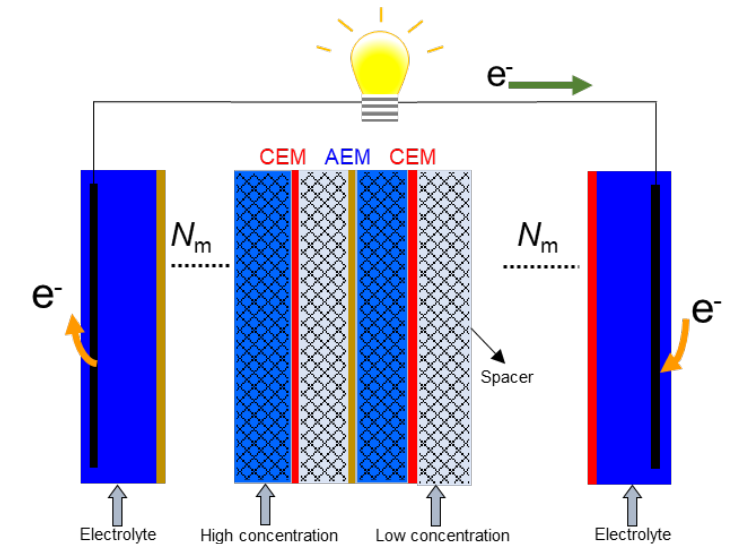
Figure 1. A simple schematic representation of a reverse electrodialysis (RED) stack including ion exchange membranes, integrated spacers, and electrodes.